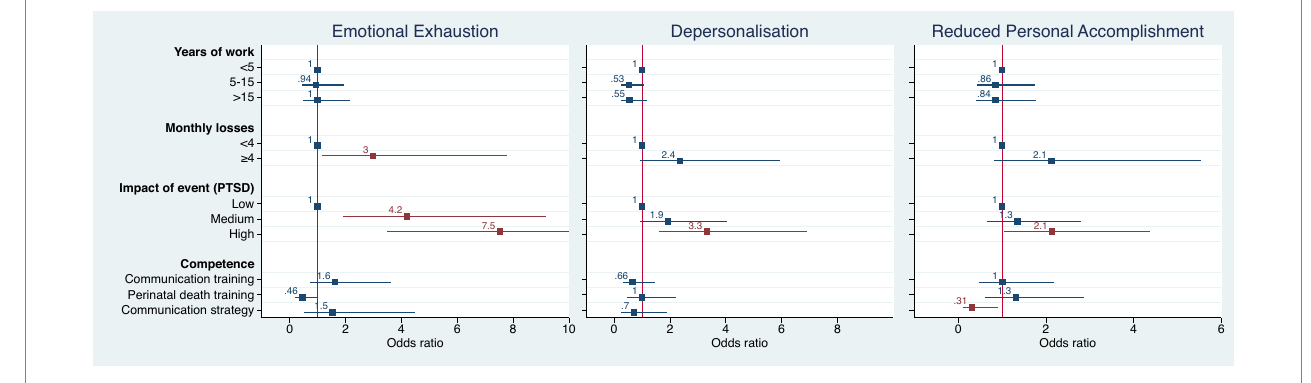
FIGURE 7 Results of a multivariate analysis showing associations between MBI subscales with several independent factors; red color p <